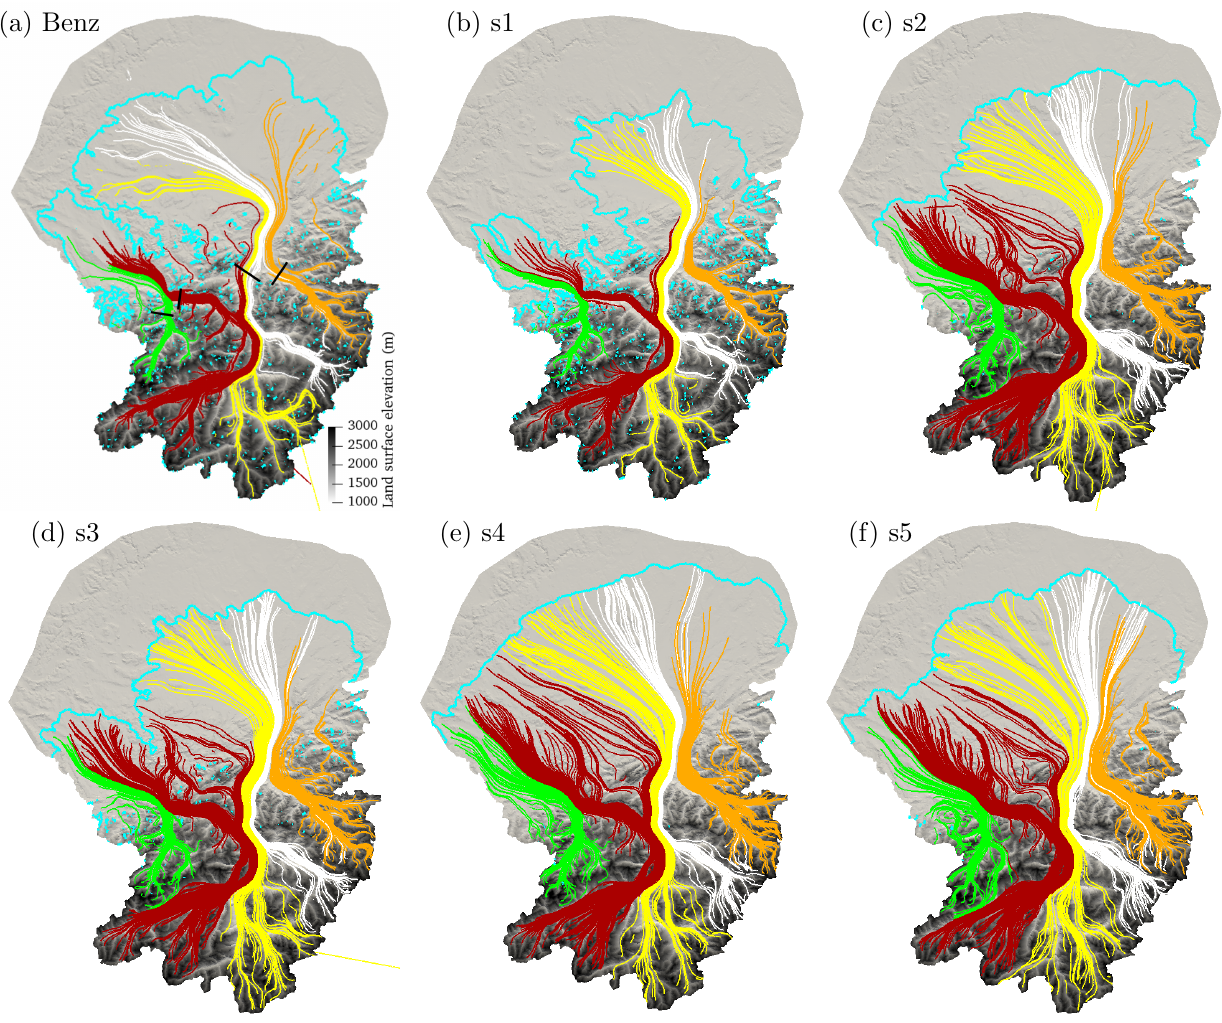
Figure 13. Three-dimensional flow lines for simulations (a) Benz-Meier (2003) after 50 years of free surface evolution and (b–f) s1–s5. Colors indicate origin of ice: (green) Linth glacier; (red) Vorderrhein; (yellow) Hinterrhein; (white) Landquart valley; (orange) Ill glacier. Black lines in (a) indicate the four gates through which ice fluxes are calculated (see Table 4). Background color is elevation of basal